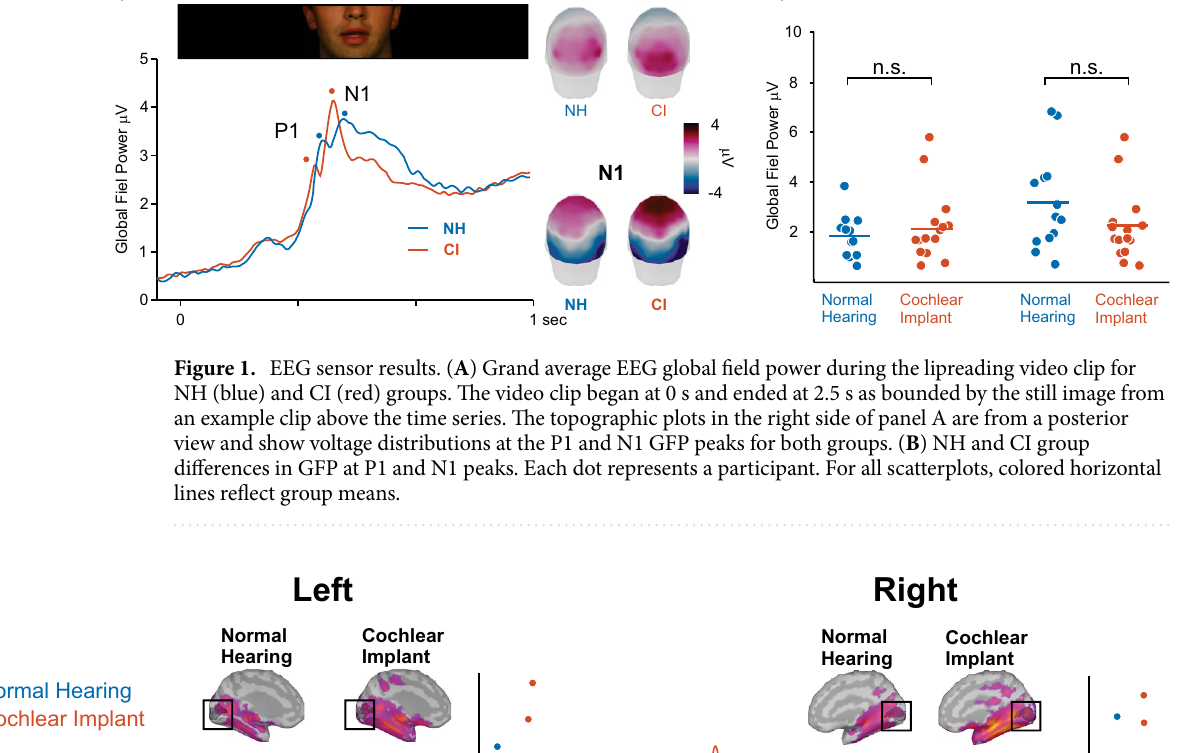
Source event-related potentials. To test for evidence of crossmodal reorganization, we used sLORETA to identify sources contributing to the N1 onset response in ROIs that covered auditory, visual, and face regions for left and right hemispheres. Figure 2 shows the time course of activation, location of each region, and subject- level data for each ROI. Nonparametric cluster-based permutation tests were first used to compare the time series of activation between groups at each ROI. The only difference was identified for the left auditory ROI, suggesting stronger N1-like onset responses in CI users compared to controls (p < 0.05). We then used a 2 × 2 × 3 ANOVA to compare onset activation magnitudes between groups for within-subjects factors of hemisphere (left